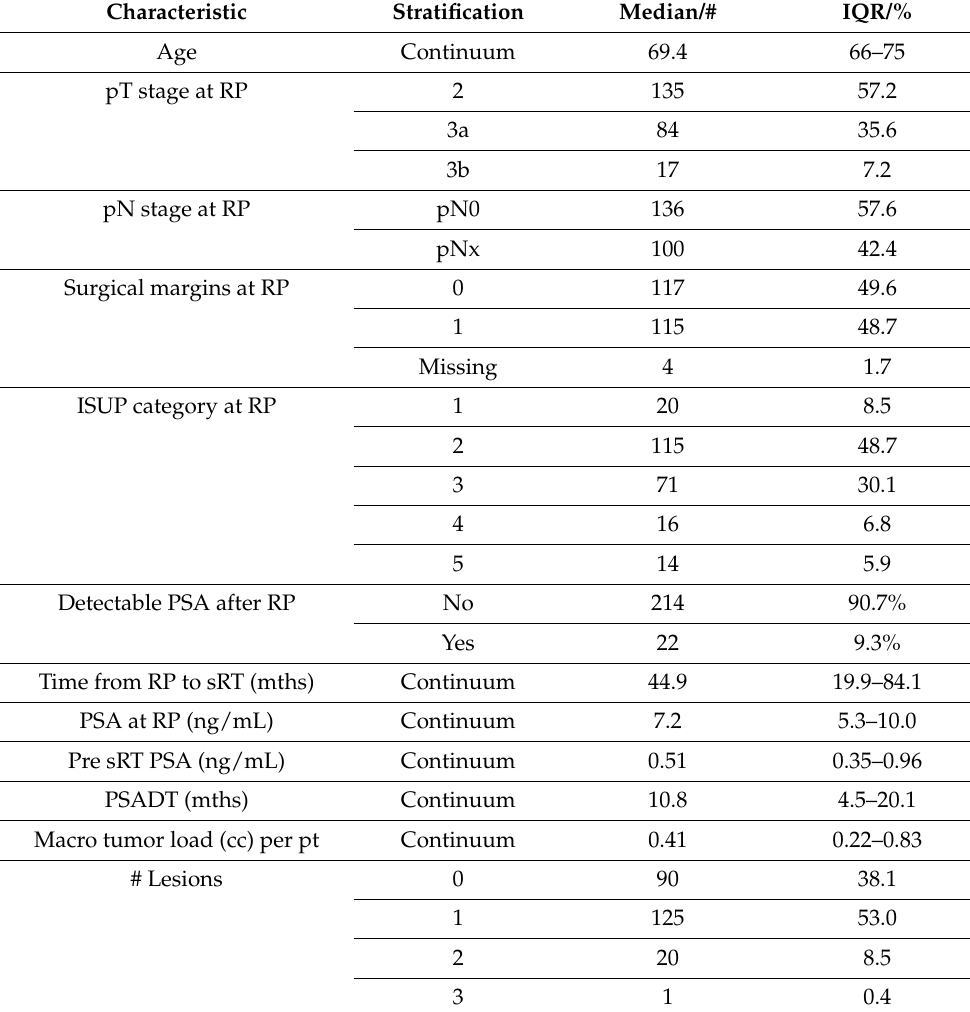
Table 1. Selected patients, tumor and treatment characteristics. Characteristic